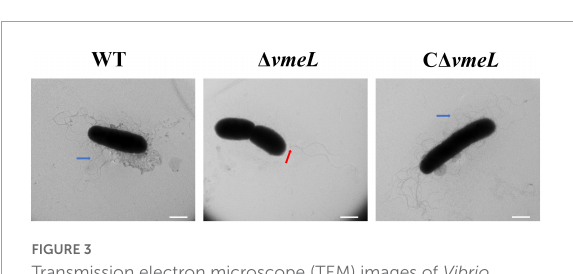
FIGURE3 Transmission electron microscope (TEM) images of Vibrio parahaemolyticus flagella. Representative images of flagella in WT, (cid:49) vmeL and C (cid:49) vmeL were observed by TEM and